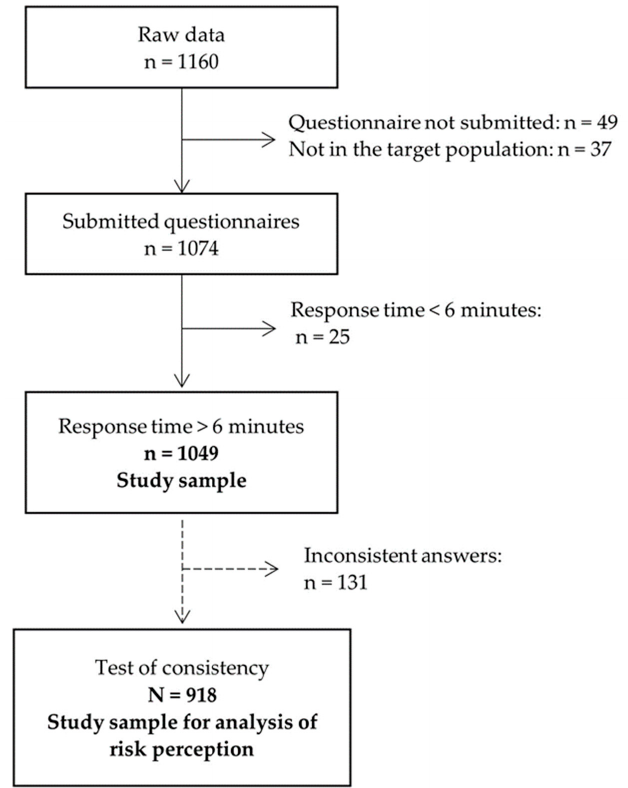
Figure 1. Sample size flow chart within data cleaning process.